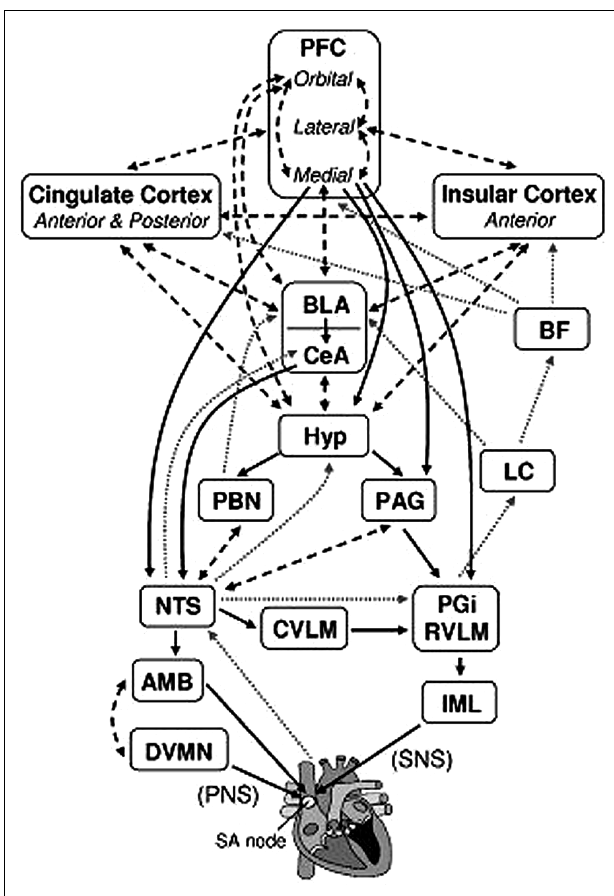
FIGURE 1 | Brain structures associated with the control of heart rate. Solid black arrows indicate efferent pathways to the heart, including right vagus nerve (PNS) and stellate ganglion (SNS) inputs to the SA node. Dotted gray arrows indicate afferent pathways to medullary structures via aortic baroreceptor signals carried through the vagus. Dashed black arrows indicate bidirectional connections. AMB, nucleus ambiguus; BF, basal forebrain; BLA, baso-lateral amygdala; CeA, central nucleus of the amygdala; CVLM, caudal ventrolateral medullary neurons; DVMN, dorsal vagal motor nuclei; Hyp, hypothalamus (lateral and paraventricular); IML, intermediolateral cell column of the spinal cord; LC, locus coeruleus; NTS, nucleus of the solitary tract; PAG, periaqueductal gray; PBN, parabrachial nucluei; PFC, prefrontal cortex; PGi, nucleus paragigantocellularis; RVLM, rostral ventrolateral medullary neurons.We adapted and modified the diagram from Ellis andThayer (2010; with permission of